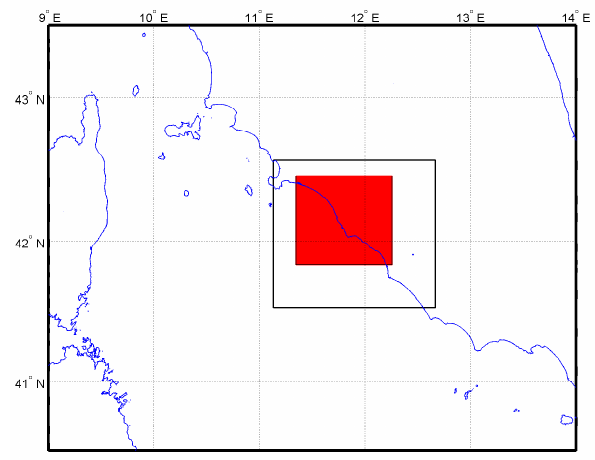
Fig. 7. Position of the regional grid (black boxes) and coastal grid (red boxes) in the Central Tyrrhenian Sea.